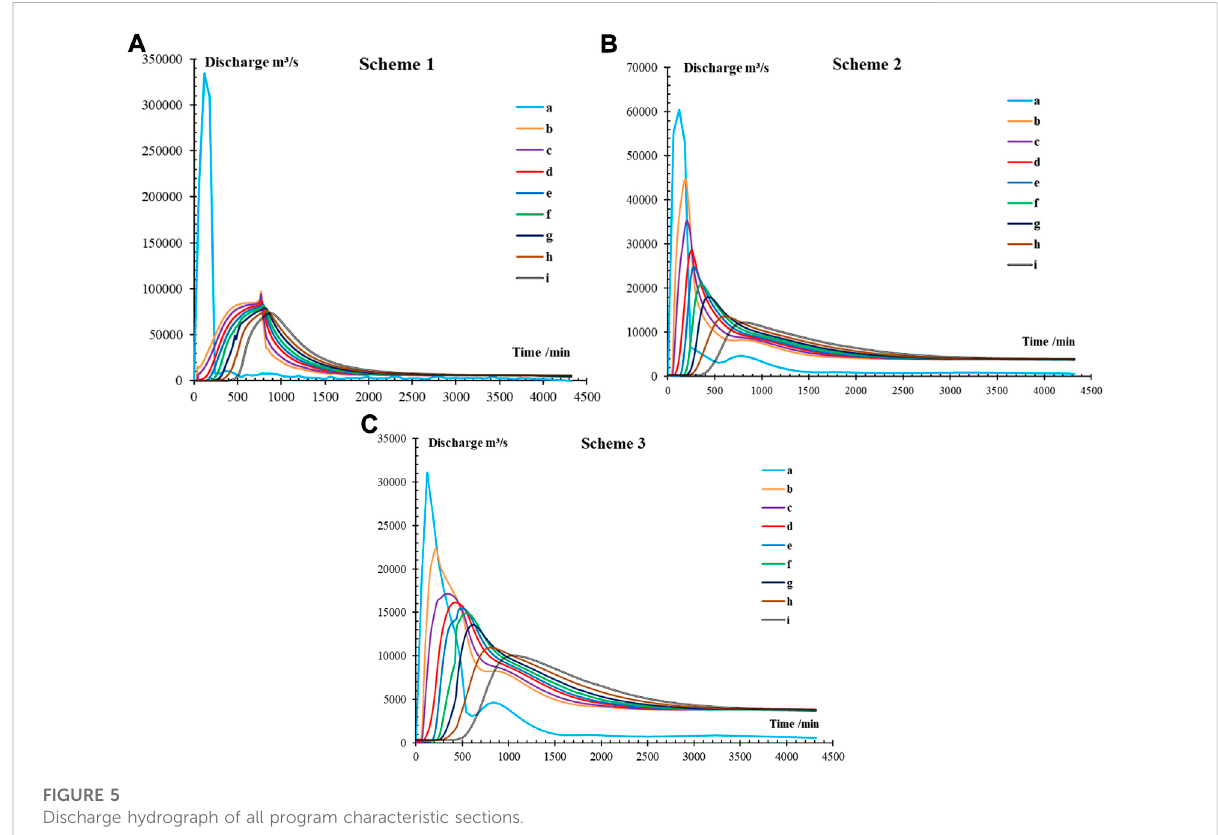
FIGURE 5 Discharge hydrograph of all program characteristic sections.